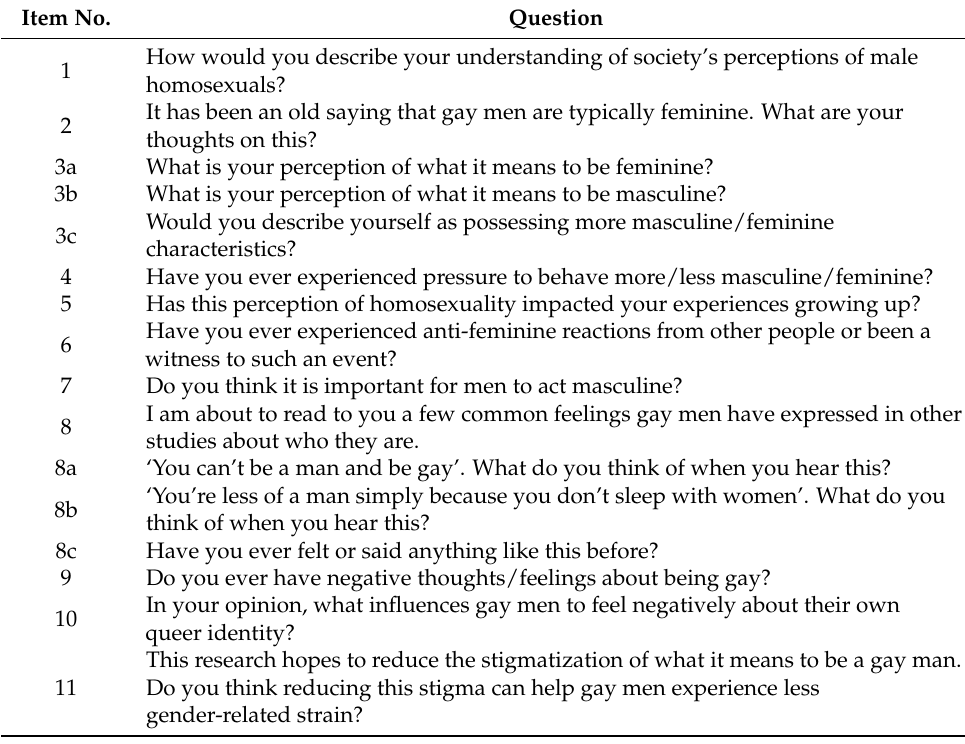
Table 1. Interview question